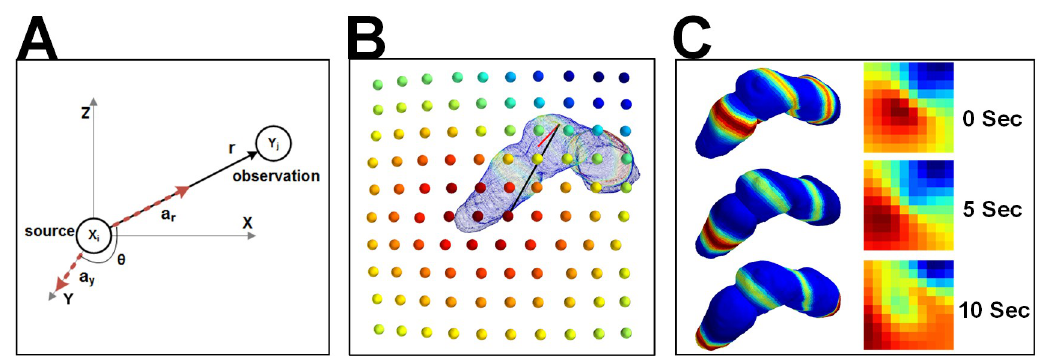
Fig 4. Dynamic dipole moment simulations and forward model. A) Forward model relationship between dynamic dipole moments (X) and observed abdominal surface potentials (Y) B) 3D models of dynamic dipole moments and observed array C) Time evolution of dipole moments and observations for normal